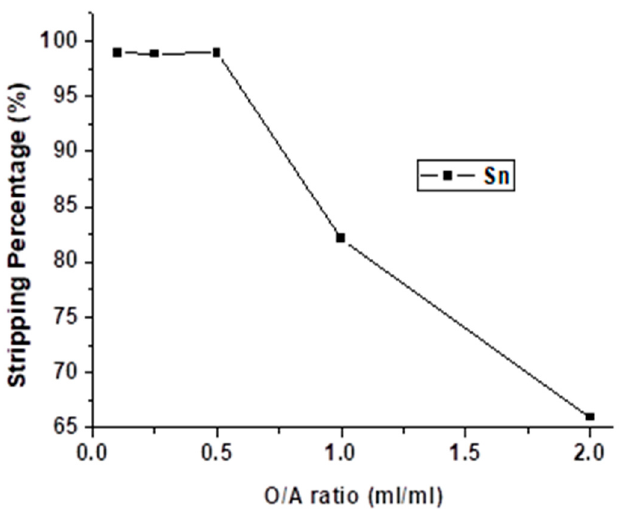
Figure 11. Stripping percentage of Sn at different O/A ratios. (HNO 3 ) = 4 M, reaction time = 5 min.